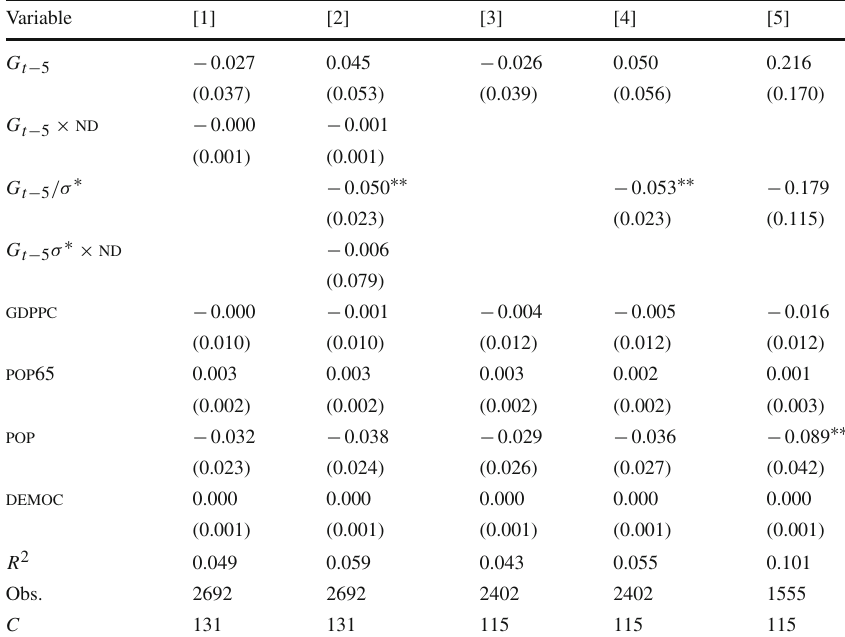
Table 4 Size of the state and inequality in democracies